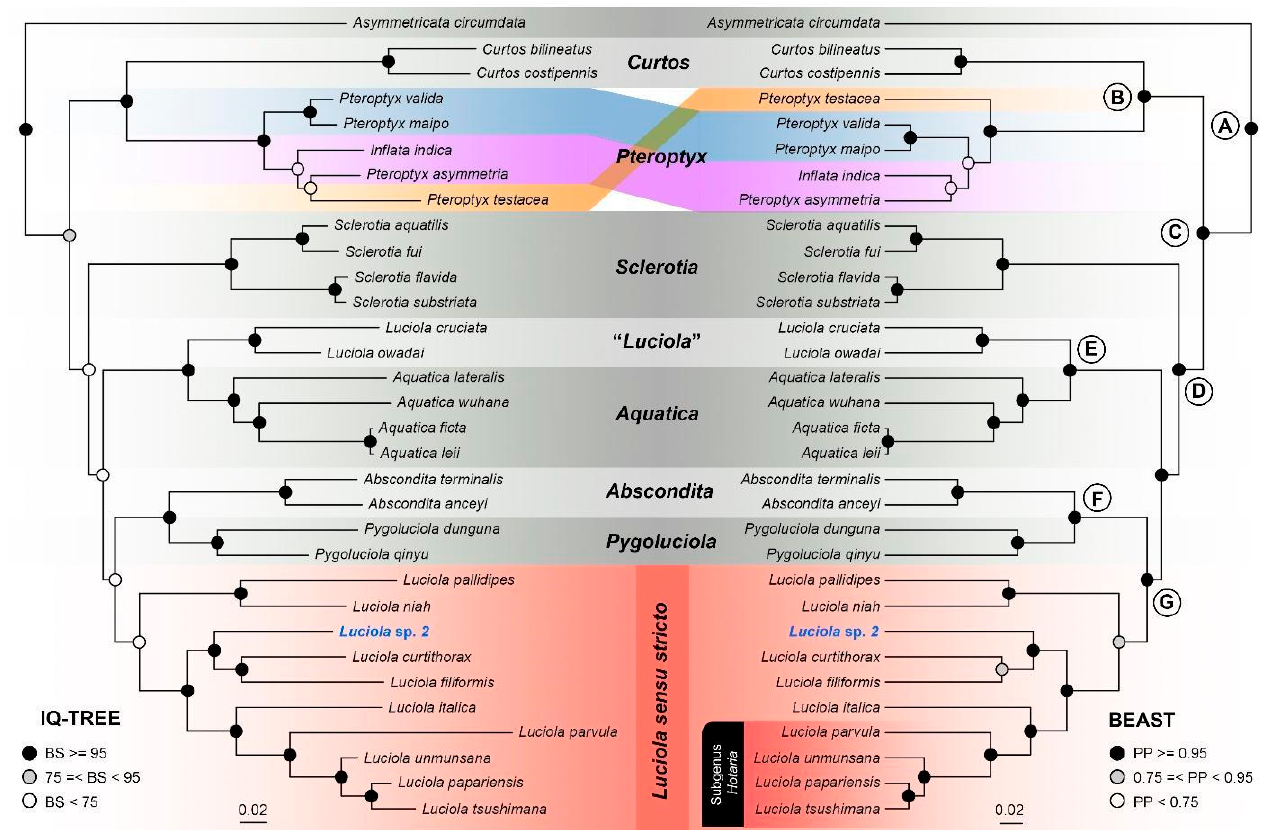
Figure 2. Heatmap of uncorrected p -distances among Luciola sp. 2 and closely-related taxa based on COX1 .